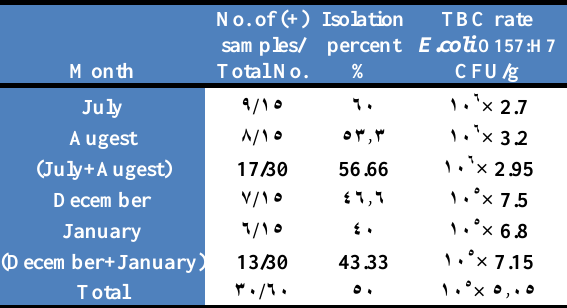
Table, 1: Bacterial isolation ( E.coli O157:H7/g) of samples during the probationary period .